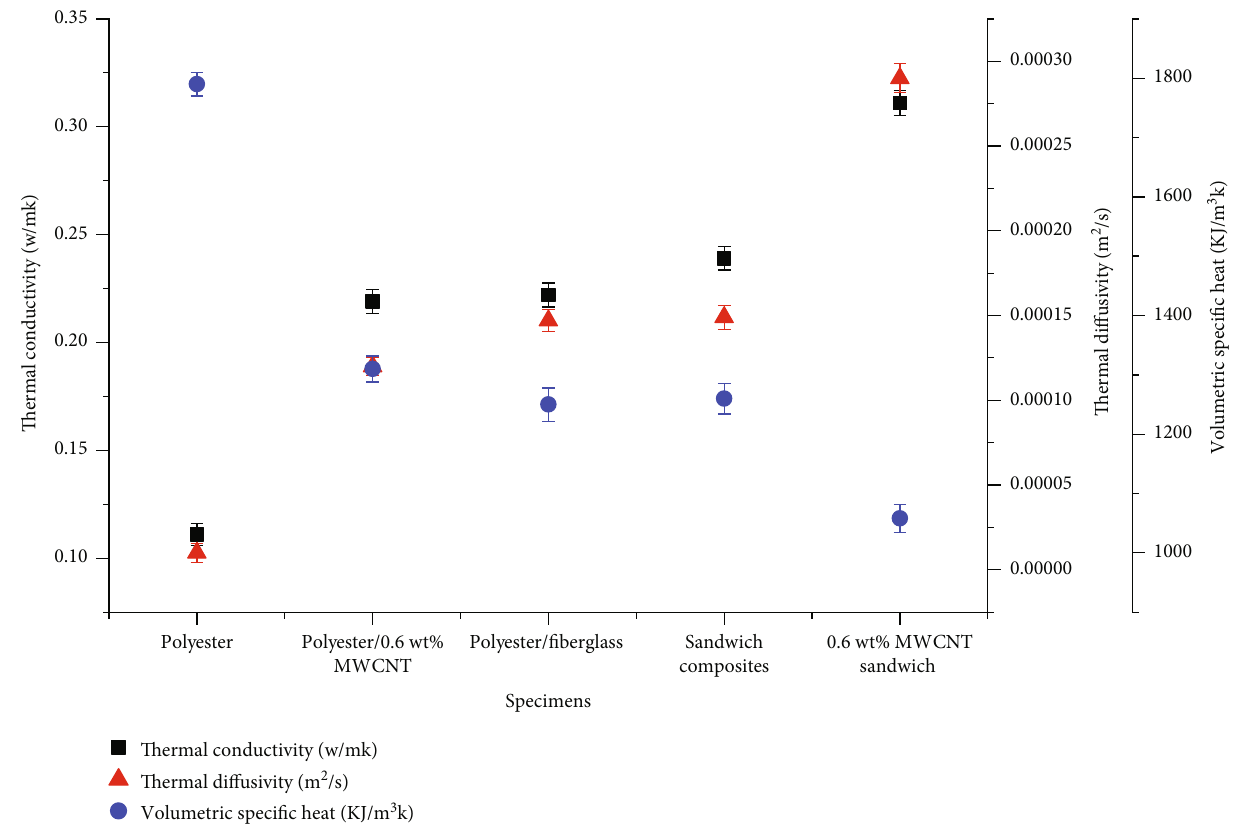
Figure 12: Weight of polyester/ fi berglass composites with various stockinette structure and weight of composites without stockinette structure